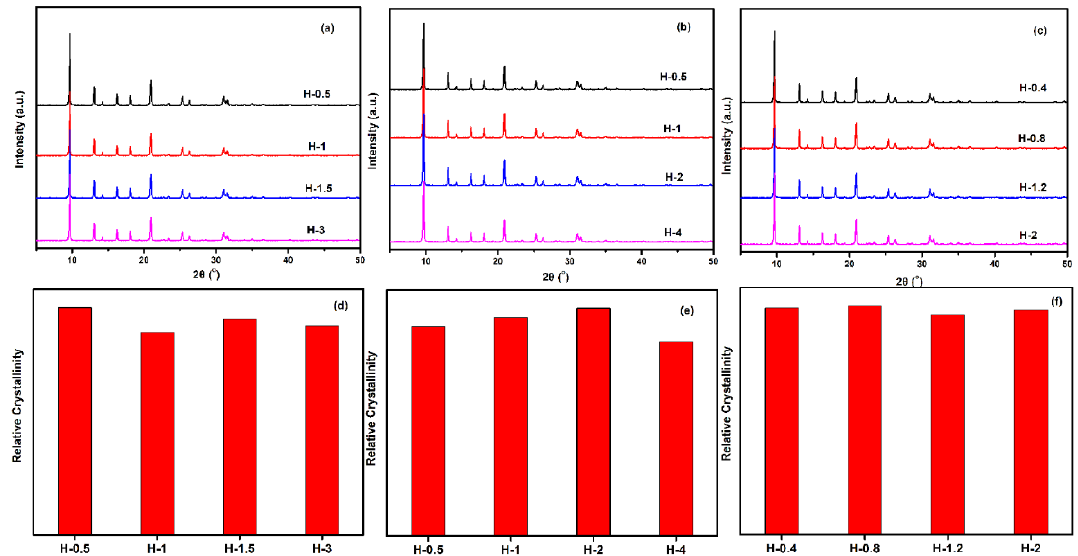
Figure 13. XRD pattern (top) and relative crystallinity (bottom) of SSZ-13s with di ff erent sizes. ( a , d ) for Si / Al = 8 SSZ-13 materials; ( b , e ) for Si / Al = 15 SSZ-13 materials; ( c , f ) for Si / Al = 25 SSZ-13 materials. Notes: The relative crystallinities for each Si / Al ratio were independently normalized. Table 5. Si/Al ratios for the obtained SSZ-13s with Si/Al = 8, 15, and 25. Samples with Low Si/Al Si/Al Samples with Middle Si/Al Si/Al Samples with High Si/Al Si/Al H-0.5 7.8 H-0.5